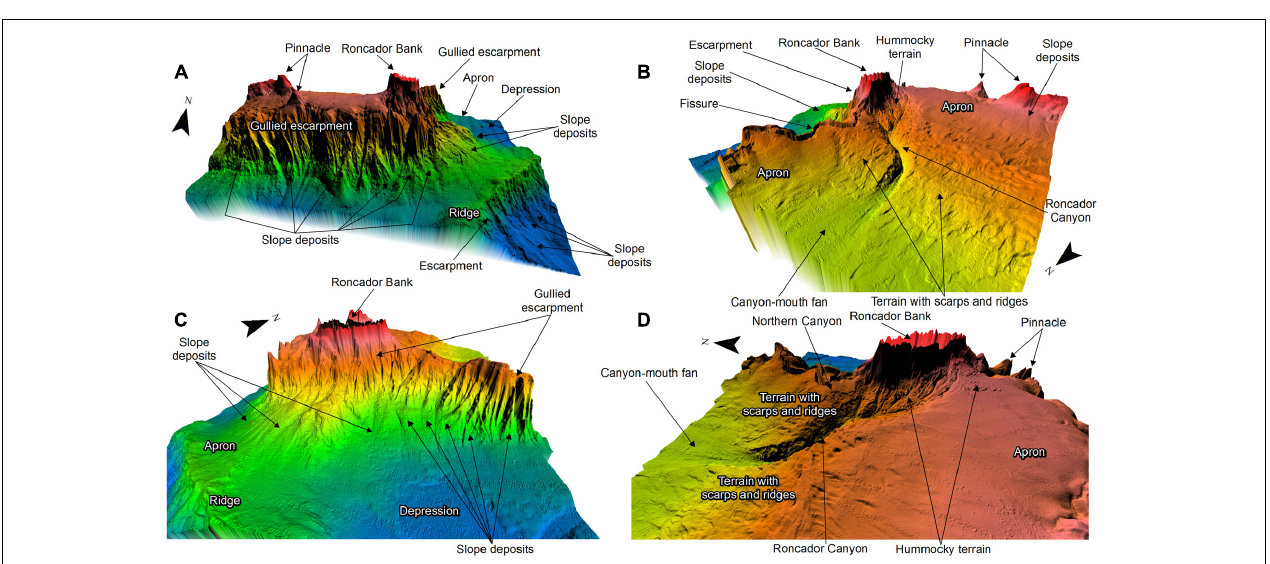
FIGURE 8 | General 3D views of Roncador Bank and adjacent areas where the main identified geoforms are highlighted. (A) View from the south. (B) View from the northwest. (C) View from the east. (D) View from the west. Vertical exaggeration is by 8. See text for detailed